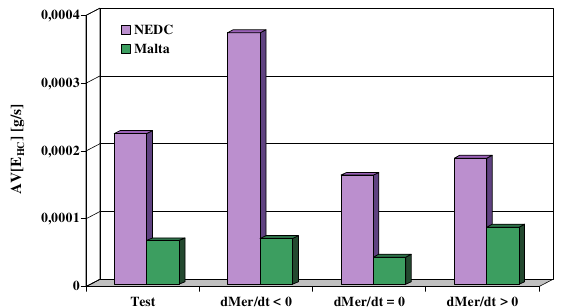
Fig. 29. Comparison of the mean hydrocarbons emission value in the test and in the states corresponding to the negative, zero and positive values of the engine speed derivative with respect to time – for the NEDC and Malta tests